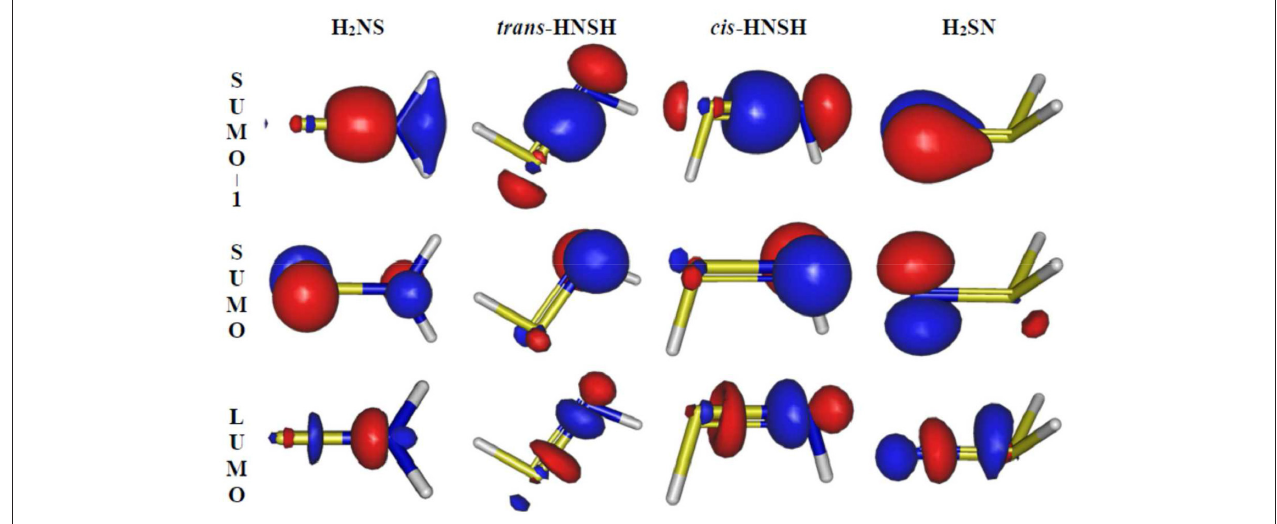
FIGURE 2 | Outermost molecular orbitals (SOMO-1, SOMO and LUMO) of the molecular species of interest obtained at the CASSCF/aug-cc-pVTZ. The isovalue is